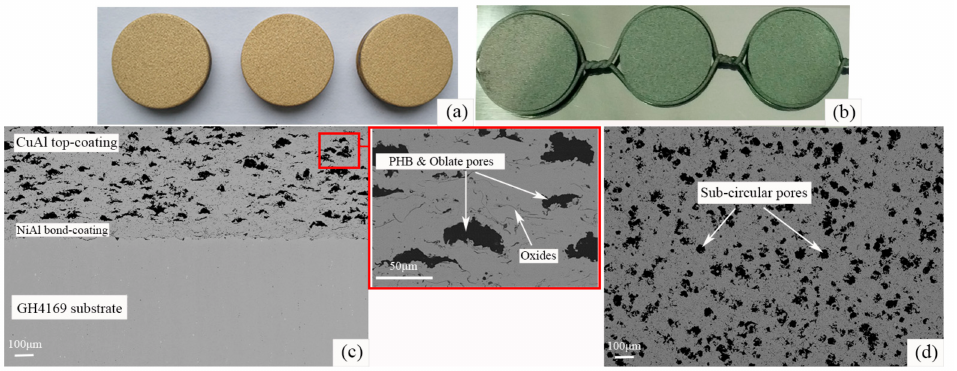
Figure 1. Surface macro morphologies of ( a ) the CuAl/PHB seal coating and ( b ) the NiAl coating; SEM images of ( c ) the cross-sectional microstructure and ( d ) the surface microstructure of the as- sprayed CuAl/PHB-NiAl abradable seal